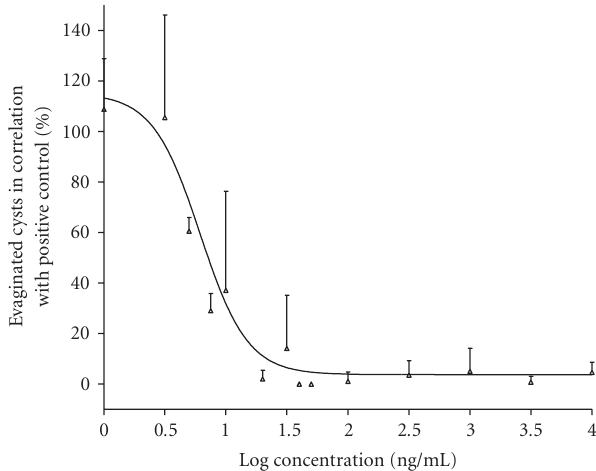
Figure 1: Percentage evaginated cysts in correlation with positive control, against the log concentration of praziquantel. The line is obtained by pooled data from four experiments and fitted to a dose-response sigmoidal curve (variable slope). The total number of cysts examined for this praziquantel study was 1803. The error bars represent standard deviation